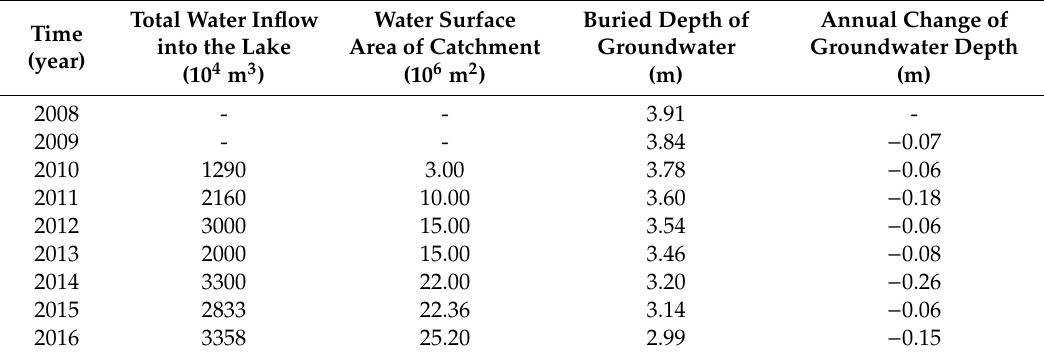
Table 1. Changes of water inflow and water quantity in Qingtu Lake from 2010 to